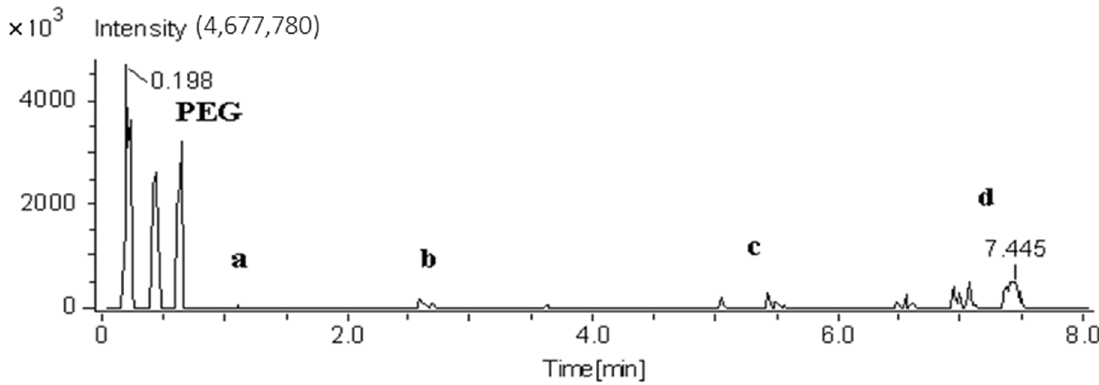
Figure 5. Total ion response of polypropylene at temperatures: ( a ) 200 °C, ( b ) 225 °C, ( c ) 250 °C, ( d ) 275 °C, and ( e ) 300 °C.